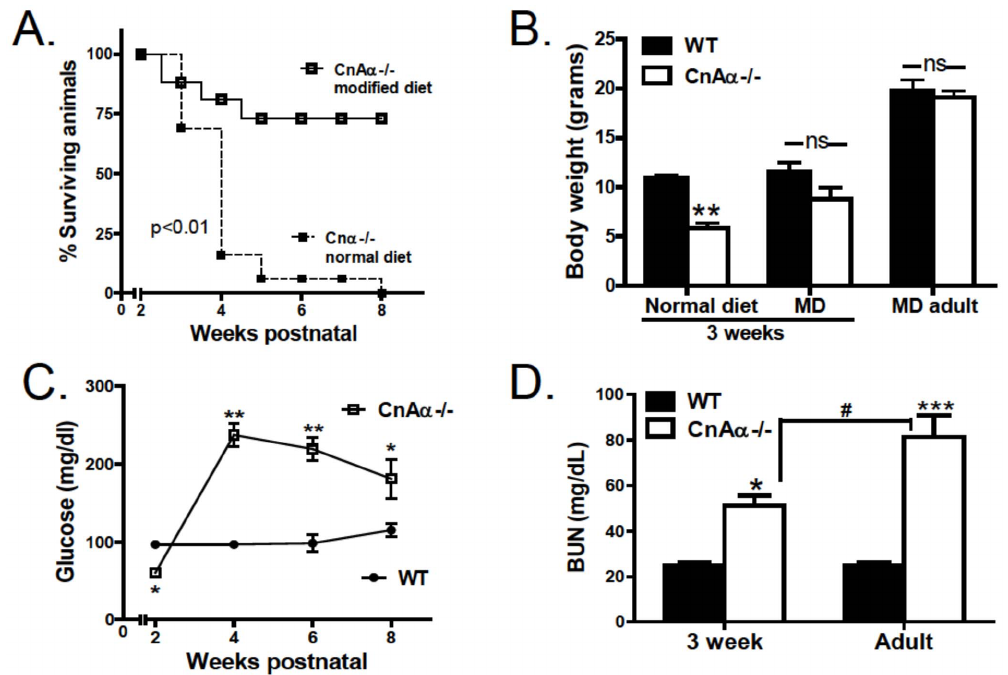
Figure 1. Kidney function of rescued CnA a 2 / 2 mice. A) Survival curve of CnA a 2 / 2 fed a conventional diet (dotted line) and the enzyme supplemented, modified diet (MD) (solid line). Data are derived from breeding records of N=40–50 mice for each group. B) Body weight of WT and CnA a 2 / 2 mice at 3 weeks of age fed the normal or MD diets were compared. Likewise, body weights of adult WT and CnA a 2 / 2 mice (approx8 weeks of age) were compared. Data shown are the mean body weights of 8 WT and 10 null mice and include both males and females. **p , 0.01 compared to WT. C) Blood glucose levels were monitored before and up to 8 weeks after supplemental feeding with the MD. Data shown are the mean blood glucose level at each time point of 8–10 mice and include both males and females. *p , 0.05 and **p , 0.01 compared to WT. D) Blood urea nitrogen measurement of 4 wildtype and 4 CnA a 2 / 2 mice at 3 weeks and 10 CnA a 2 / 2 mice at 8 weeks of age. *p , 0.05 and ***p , 0.001 compared to WT; # p , 0.05.